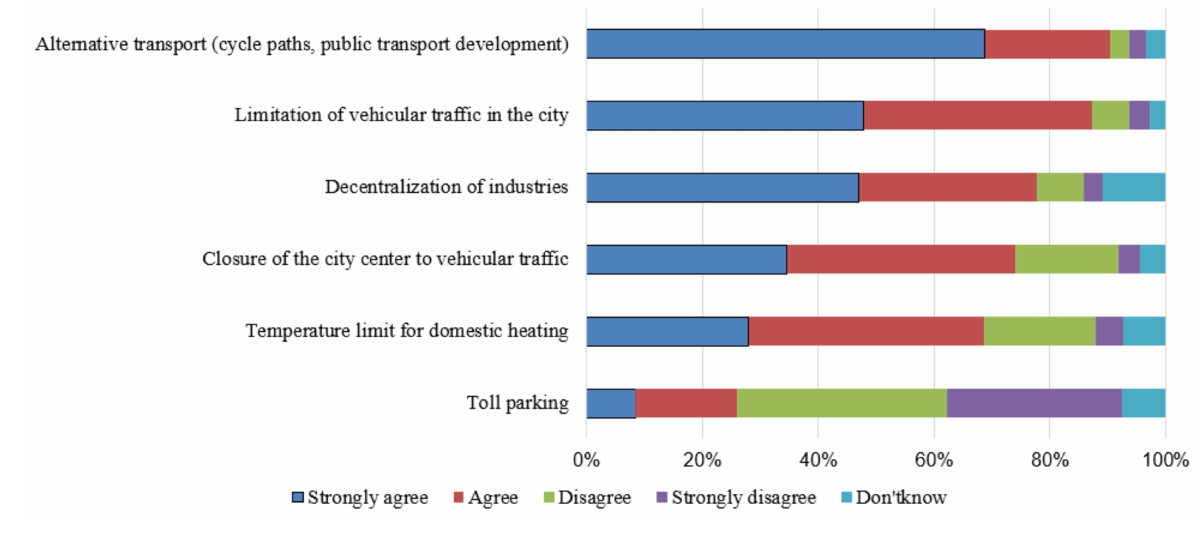
Figure 2. Level of support of measures to limit air pollution.